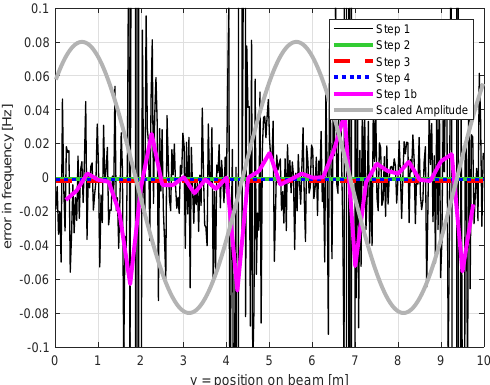
Figure 6. Results of basic set-up: errors in frequency. For reasons of clarity, the vertical axis is limited to errors with an absolute magnitude of 0.1 Hz although values increase up to several